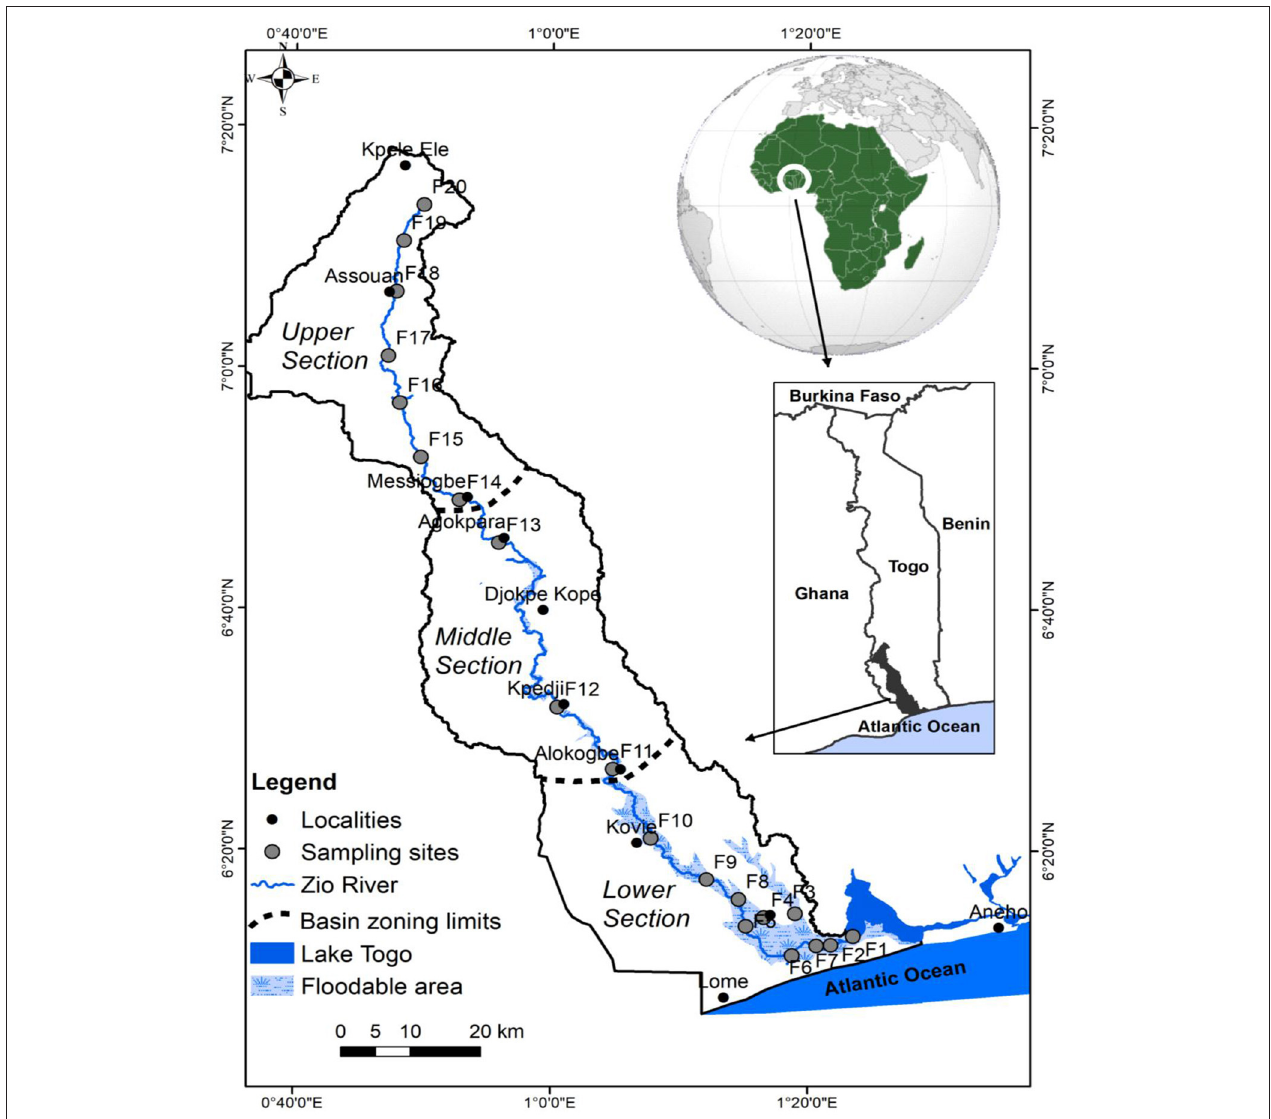
FIGURE 1 | The study area and sampling site localities for the present